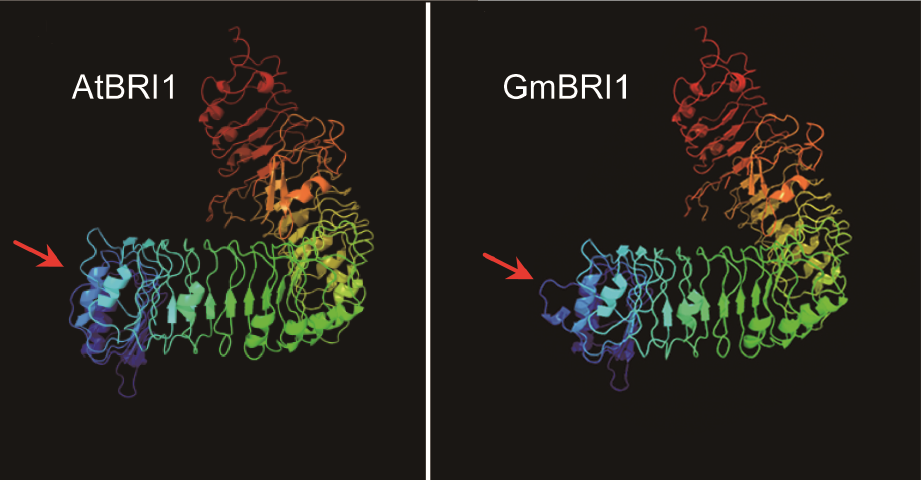
Figure 2. Predicted tertiary protein structure of the GmBRI1 and AtBRI1 proteins. Arrows indicate the differing